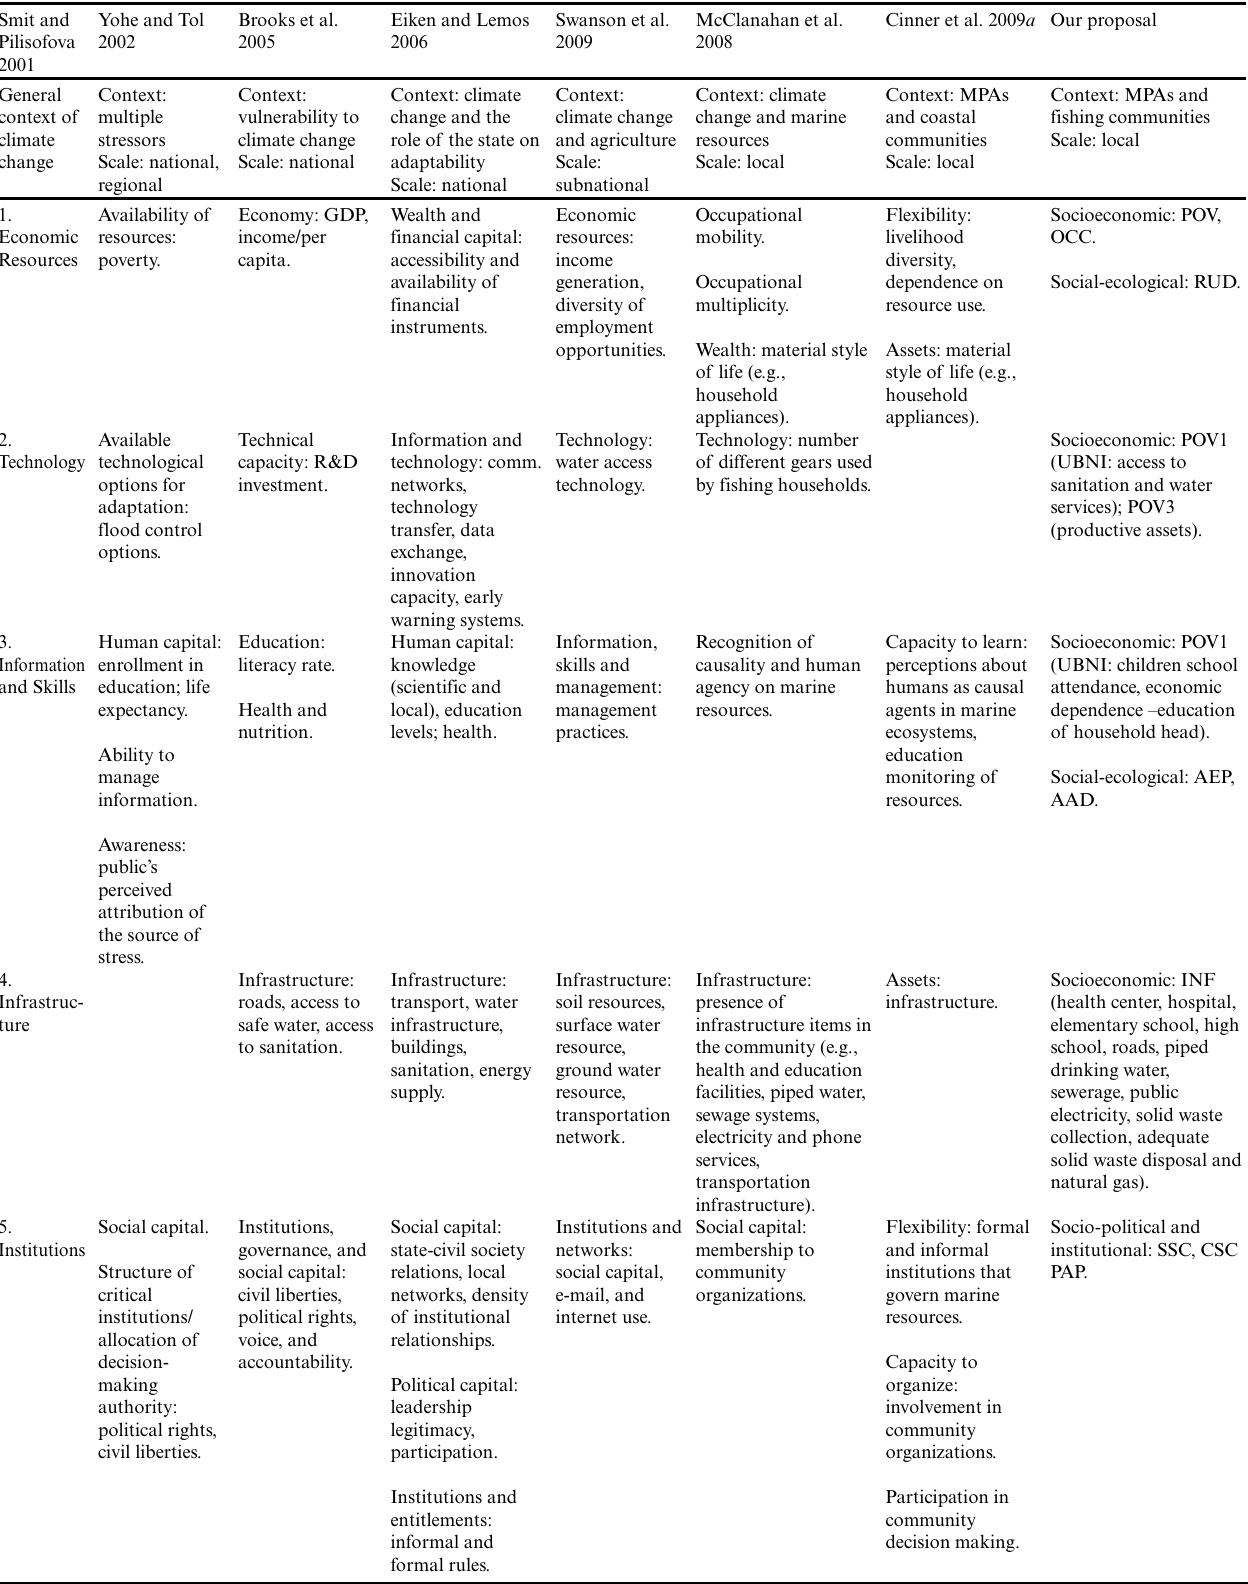
Table 1 . Determinants and indicators of adaptive capacity: comparison of different approaches and our